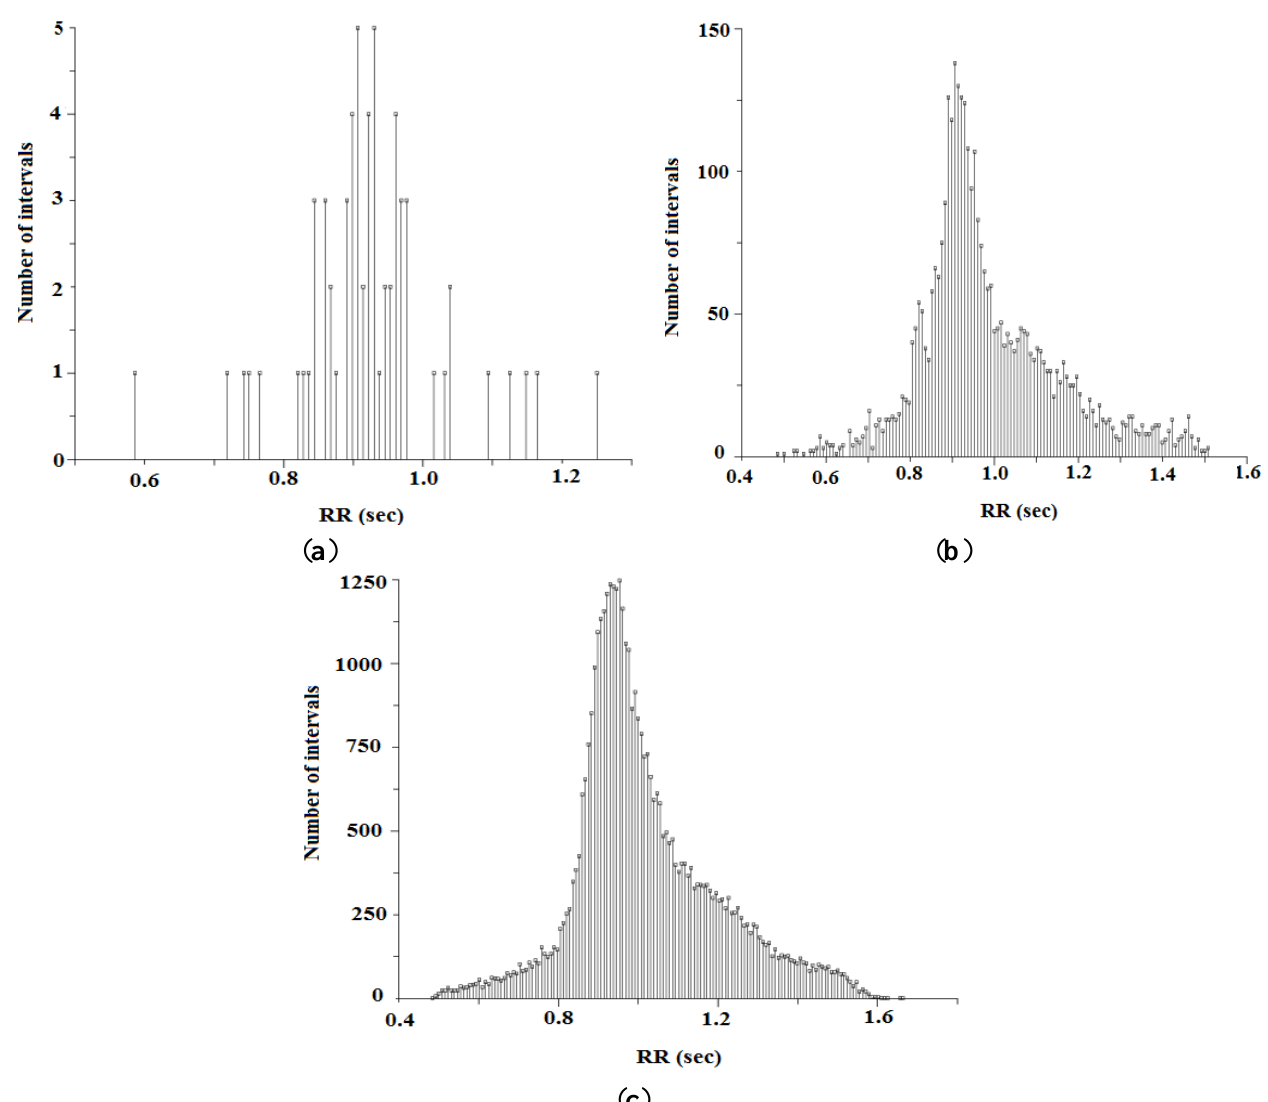
Figure 9. ( a ) Histogram representation of RR-interval for 1 min; ( b ) histogram representation of RR-interval for 1 h; and ( c ) histogram representation of RR-interval for complete wave.